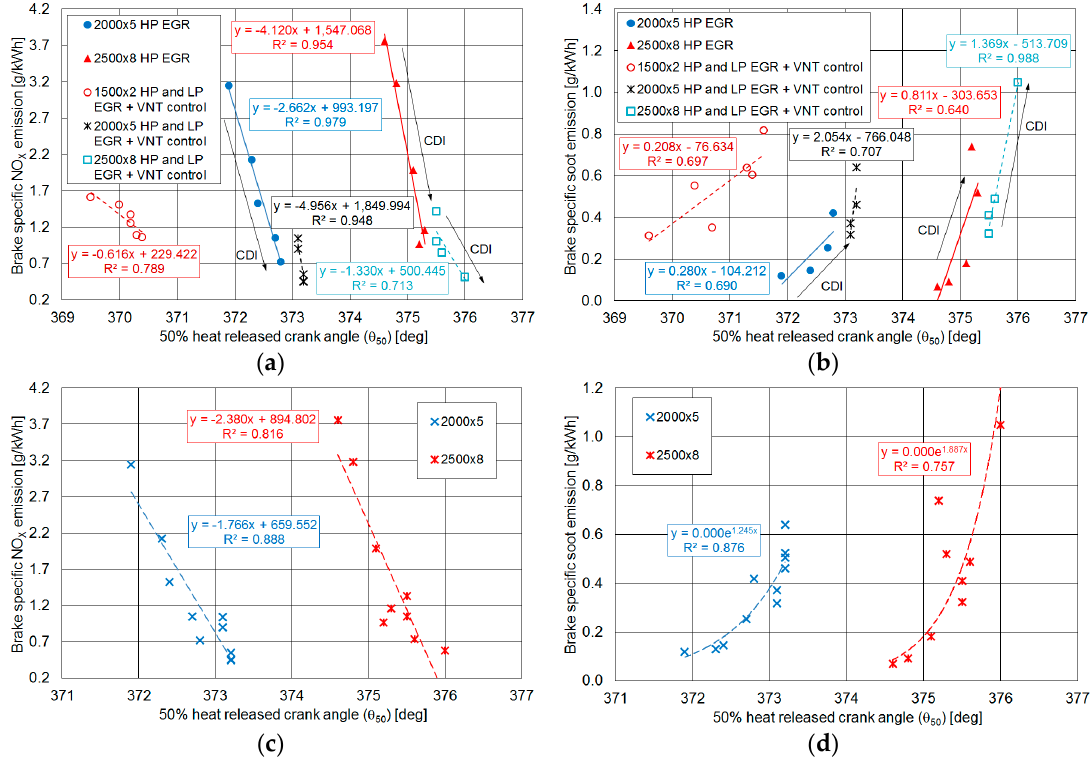
Figure 14. Link between 50% heat released crank angle and brake specific emissions (NO X ( a ) and ( c ), soot ( b ) and ( d )) in different test sets.